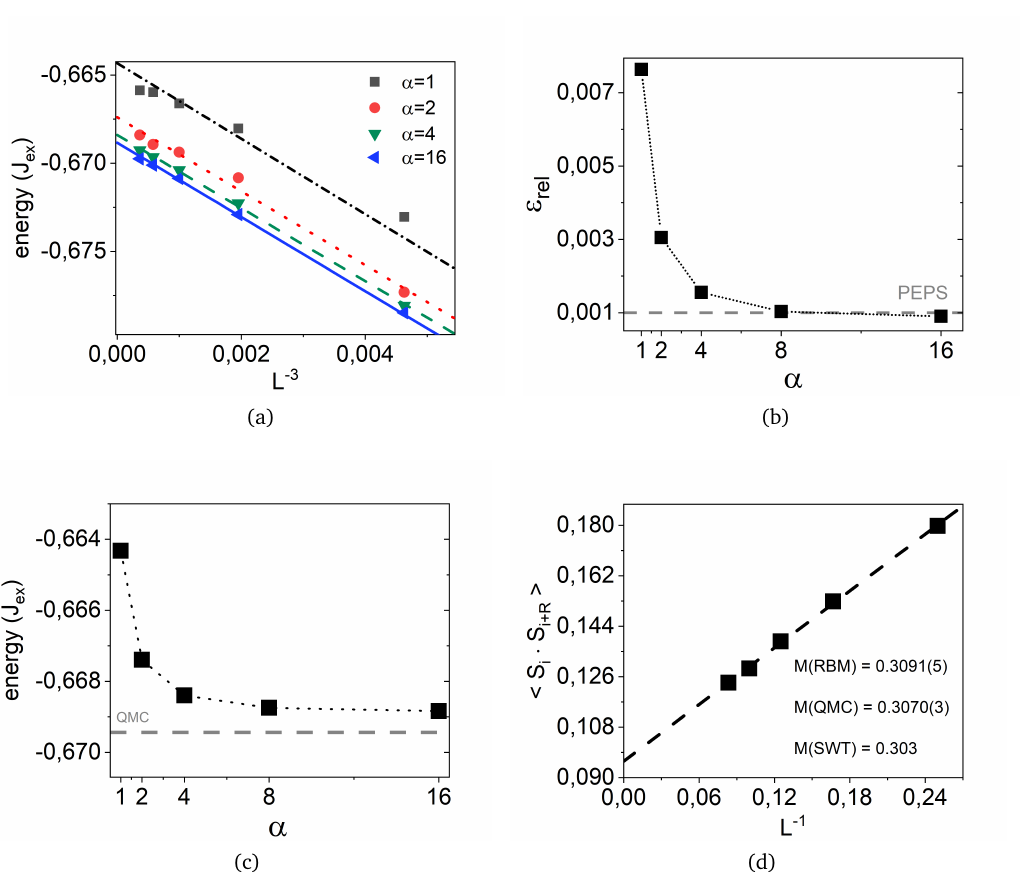
Figure 1: (a) Scaling of the ground state energy with system size L and density of hidden units α . The lines are linear fits through the numerically obtained data points. (b) Relative error ε with respect to QMC as function of α for N = 144; the dashed rel line shows the error for PEPS [ 18 ] . The extrapolations from the fits for several α are shown in (c) and compared with QMC (dashed gray line) (d) Scaling of the spin correlation between the furthest spins in the lattice with system size. The dashed line is a linear fit from which the staggered magnetization M is obtained. The extracted M is shown in the inset and is found to be very close to the numerically exact QMC result [ 16 ] . For comparison also M obtained from linear spin-wave theory is